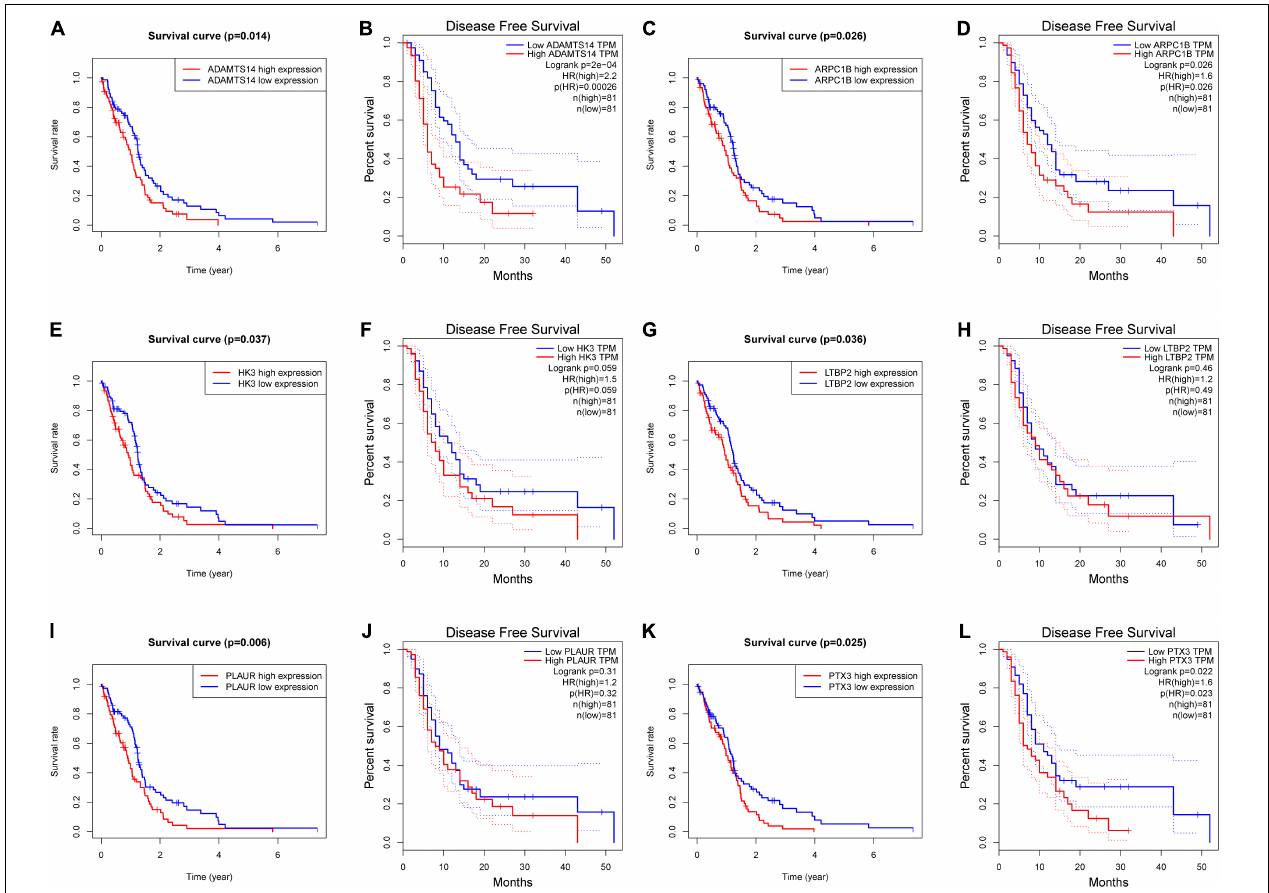
FIGURE 2 | The prognostic value of six potential GBM mRNA antigens. K-M curves showed the overall survival (OS) and disease-free survival (DFS) of patients with GBM in the different expression levels of (A,B) ADAMTS14, (C,D) ARPC1B, (E,F) HK3, (G,H) LTBP2, (I,J) PLAUR, and (K,L) PTX3. Genes with P -value < 0.05 were considered significantly correlated to the prognosis of GBM. DFS, disease-free